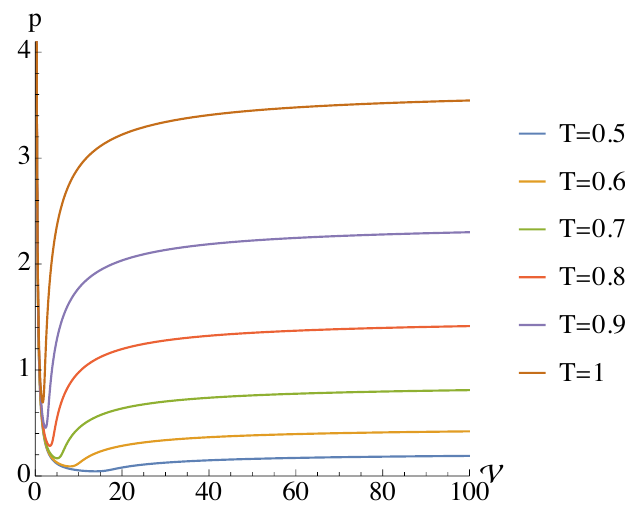
Figure 6 . No p − V criticality for holographic CFTs. The p − V phase diagram for the CFT is very different from that of the Van der Waals fluid. At fixed C and ˜ Q , the diagram shows the same qualitative behaviour for all T . In particular, there is no critical temperature at which the curve displays an inflection point. The parameters used here are ˜ Q = C = 1 and d = 4 , but the same qualitative behaviour applies in other dimensions d > 2